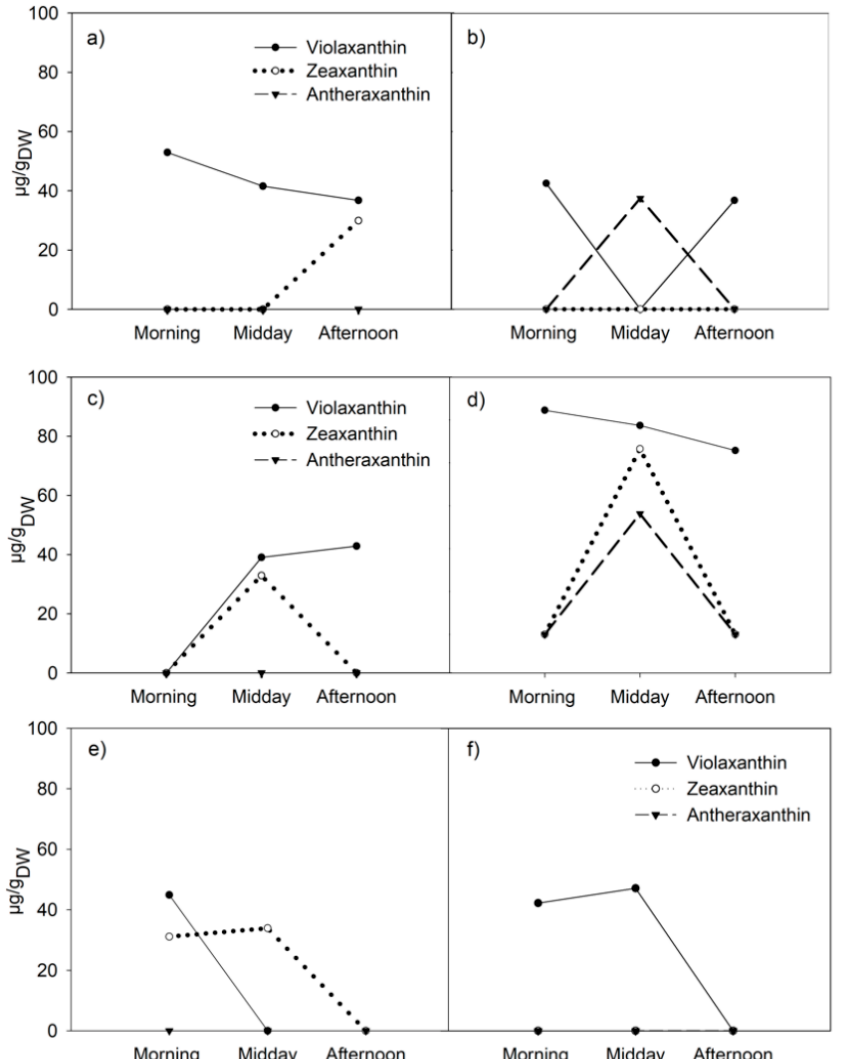
Figure 3. Diurnal variations in xanthophyll cycle pigments in Festuca curvifolia ( a , b ), Erysimum penyalarense ( c , d ), and Senecio carpetanus ( e , f ) collected at 1980 m in two climatically contrasting years. Figures for each species correspond to the 2018 growing season (left panel) and the 2019 growing season (right panel).